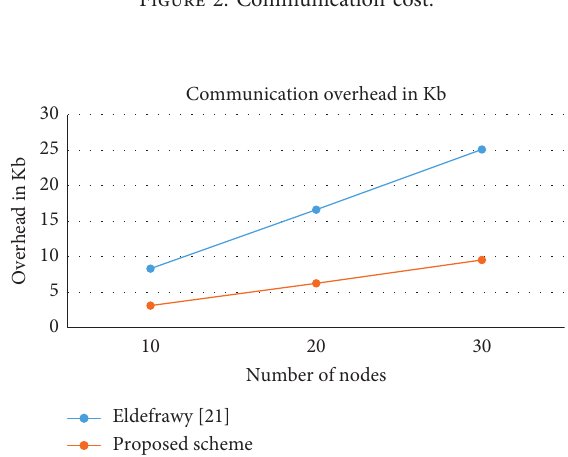
Table 4: Number of bits exchange. Figure